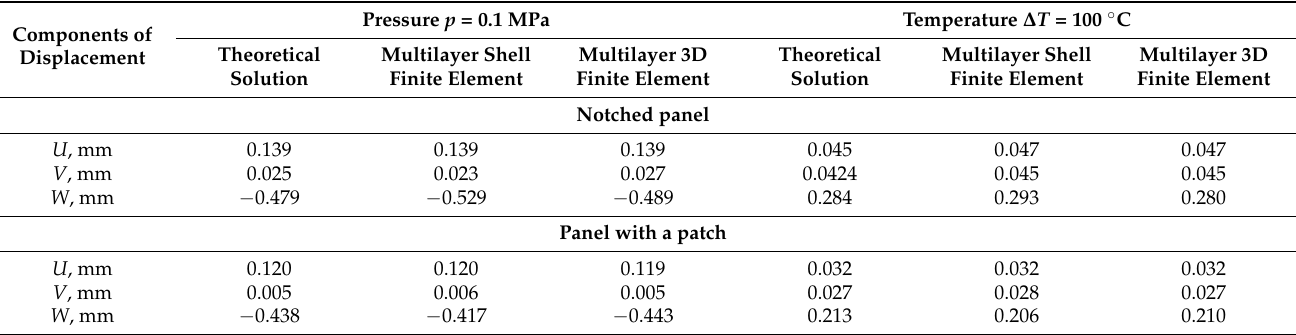
Table 5. Comparative analysis of displacements.